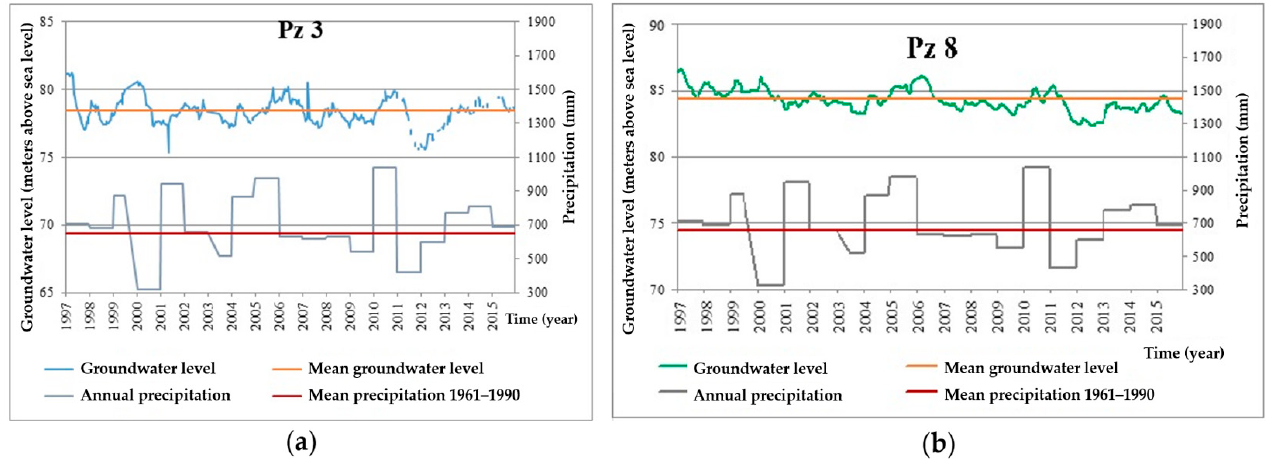
Figure 9. ( a ) Fluctuation of groundwater levels in Pz 3 in the period 1997–2015; ( b ) fluctuation of